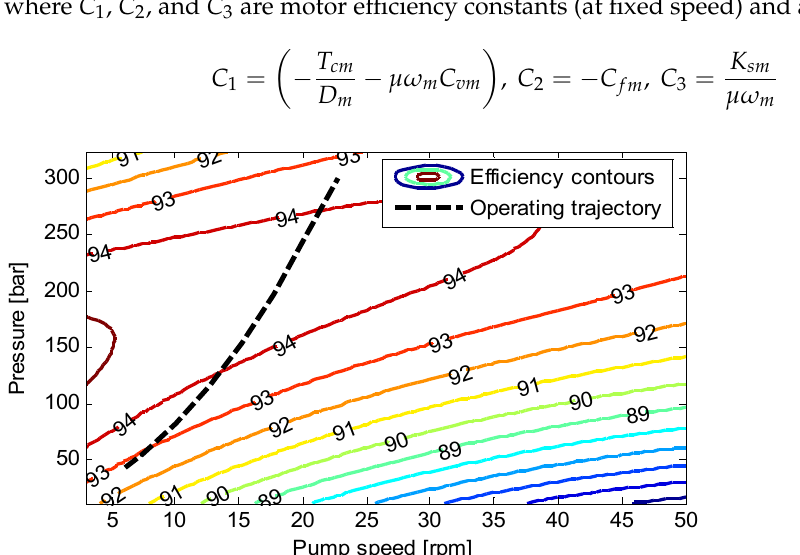
Figure 2. Efficiency contours of a piston pump used in wind turbine applications.